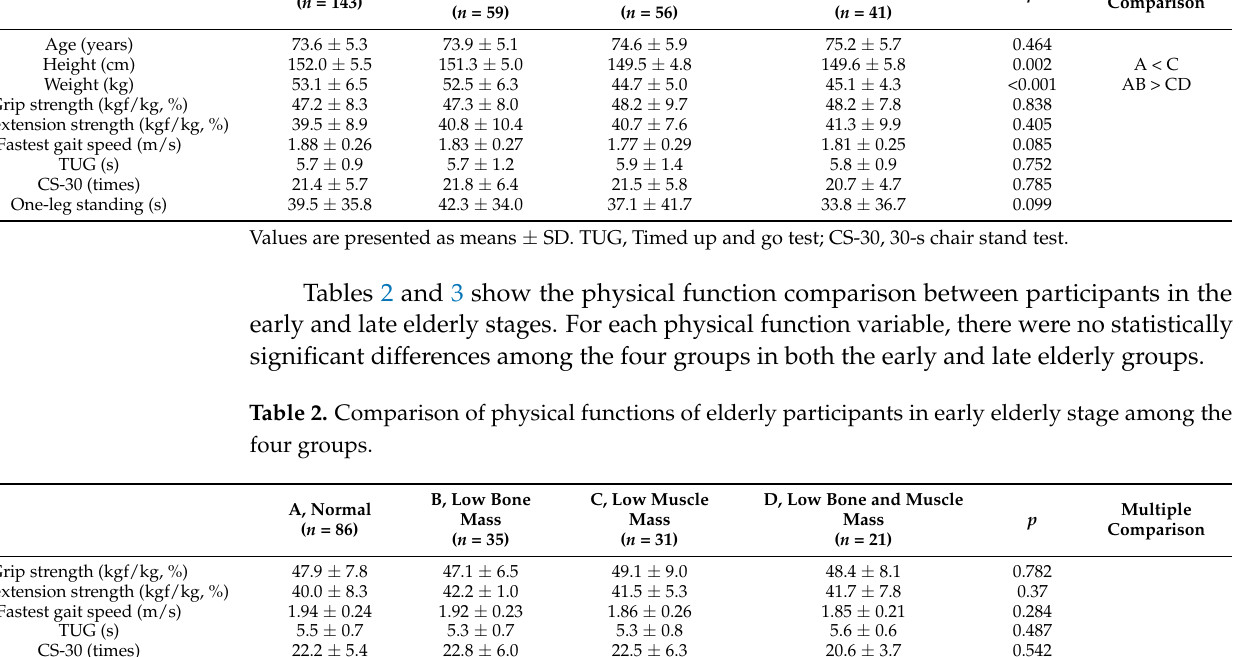
Table 1. Comparison of basic attributes and physical function among the four groups. A, Normal ( n = 143)